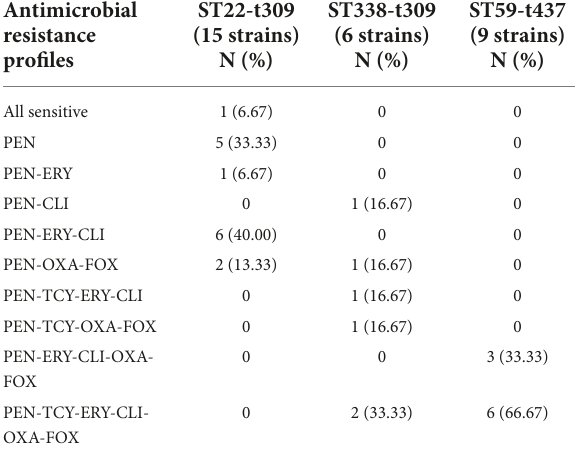
TABLE 7 Antimicrobial resistance profiles of ST22-t309, ST338-t437, and ST59-t437. Antimicrobial resistance